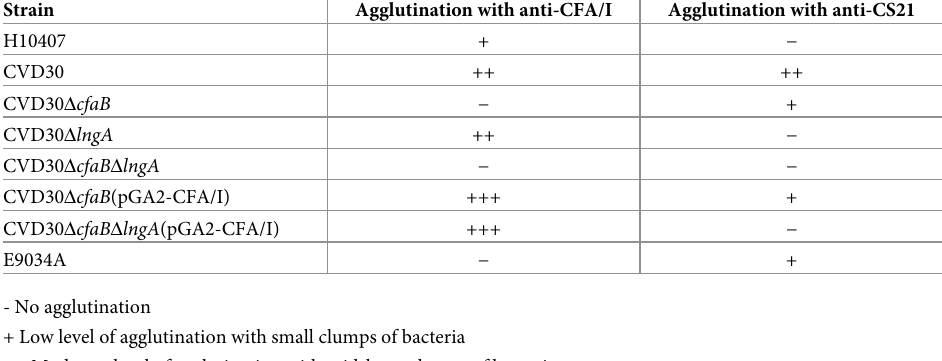
Table 3. Slide agglutination to detect CF surface expression. Strain Agglutination with anti-CFA/I Agglutination with anti-CS21